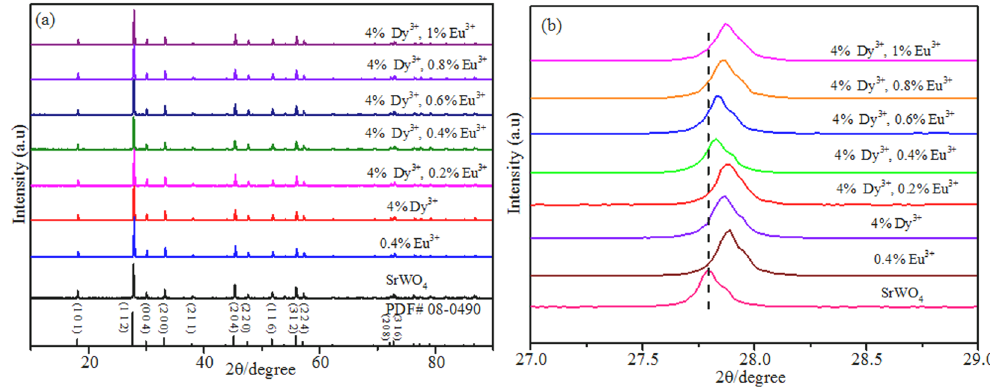
Figure 1. ( a ) XRD patterns of the as-synthesized SrWO 4 , SrWO 4 : 0.4 mol% Eu 3 + , and SrWO 4 : x Eu 3 + , 4 mol% Dy 3 + ( x = 0, 0.2 mol%, 0.4 mol%, 0.6 mol%, 0.8 mol%, 1 mol%) phosphors. The standard data of tetragonal SrWO 4 (PDF# 08-0490) is given as a reference; ( b ) Partially enlarged XRD patterns of the corresponding phosphors (2 θ = 27–29°).